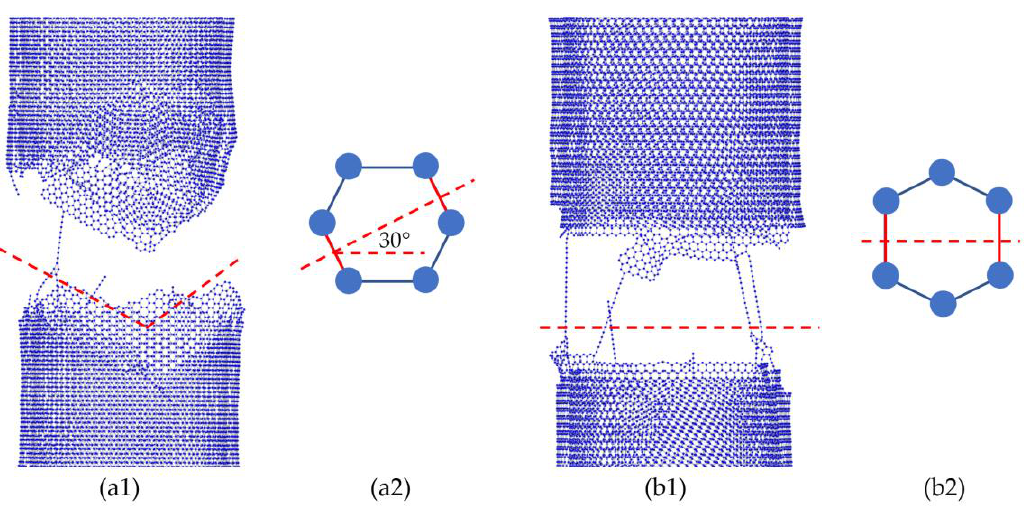
Figure 6. Fracturebehaviordifferencebetweenzigzag-typeandarmchair-type2WCNTs. ( a1 )Approximately Figure 6. Fracture behavior difference between zigzag-type and armchair-type 2WCNTs. ( a1 ) 30 ◦ fractureforarmchair-typeCNT;( b1 )Nearlylinearfractureforzigzag-typetube;( a2 , b2 )Atomarrangement Approximately 30° fracture for armchair-type CNT; ( b1 ) Nearly linear fracture for zigzag-type tube; of armchair-type CNT and zigzag-type CNT, ( a2 , b2 ) Atom arrangement of armchair-type CNT and zigzag-type CNT, respectively.